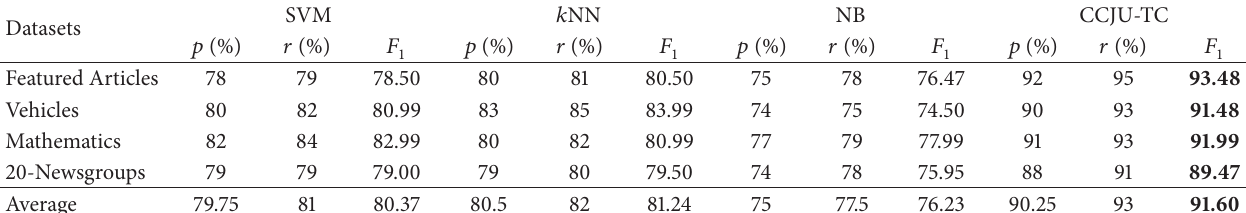
Table 4: Classification performance of different classifier with FAS.